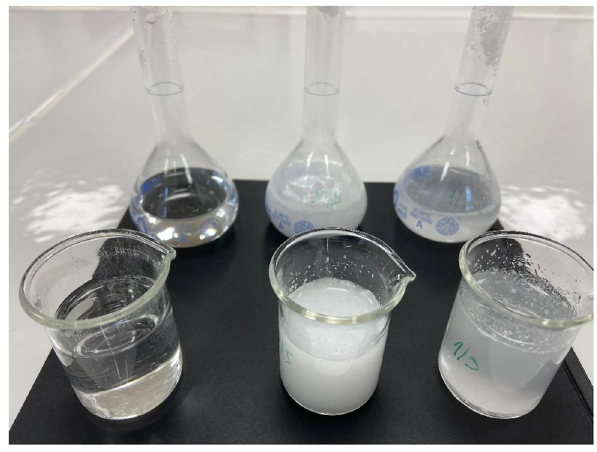
Figure2: Forthefurosemide – nefopammixture,the1/9ratio(right) was opalescent and the 1/1 ratio (in the middle)was whitishafter its preparation (T